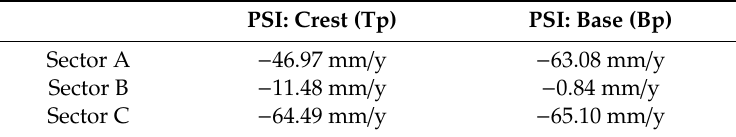
Table 3. PSI deformation rate for each